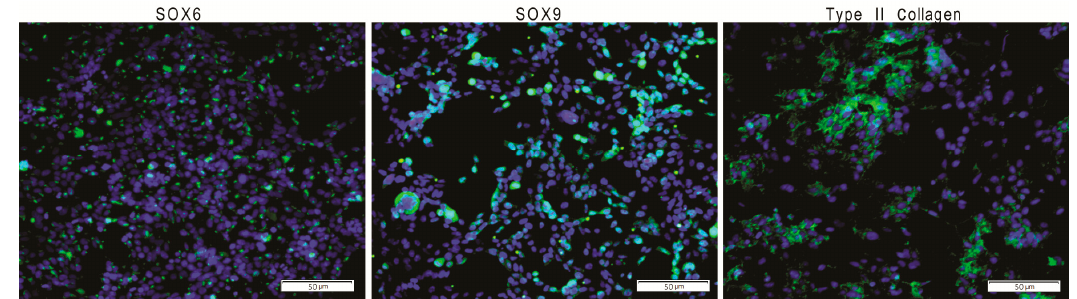
Figure 1. The GPCCi001-A cell line has the capacity to successfully differentiate into chondrogenic lineage (ChiPS) via previously established protocols. ChiPS cells reveal the presence of desirable chondrogenic markers, including SOX6, SOX9, and type II collagen visible as a green fluorescence. Nuclei are counterstained with DAPI.